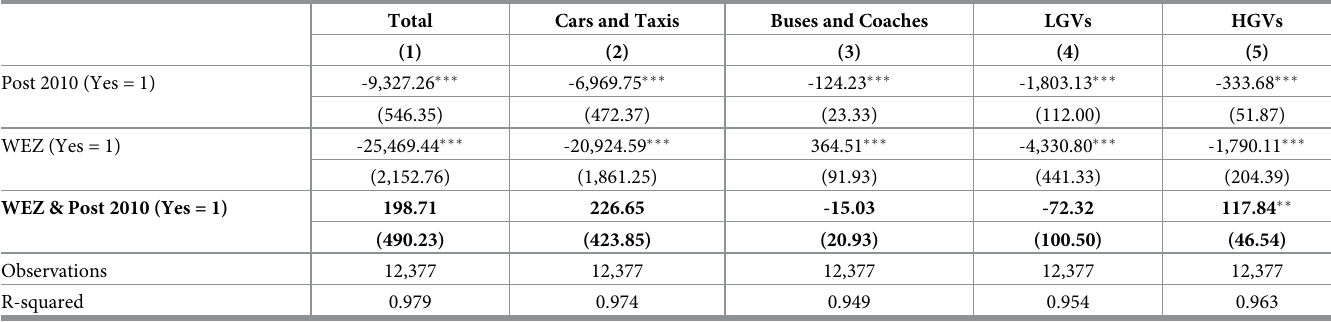
Table 2. DiD estimates from analysis for the removal of the